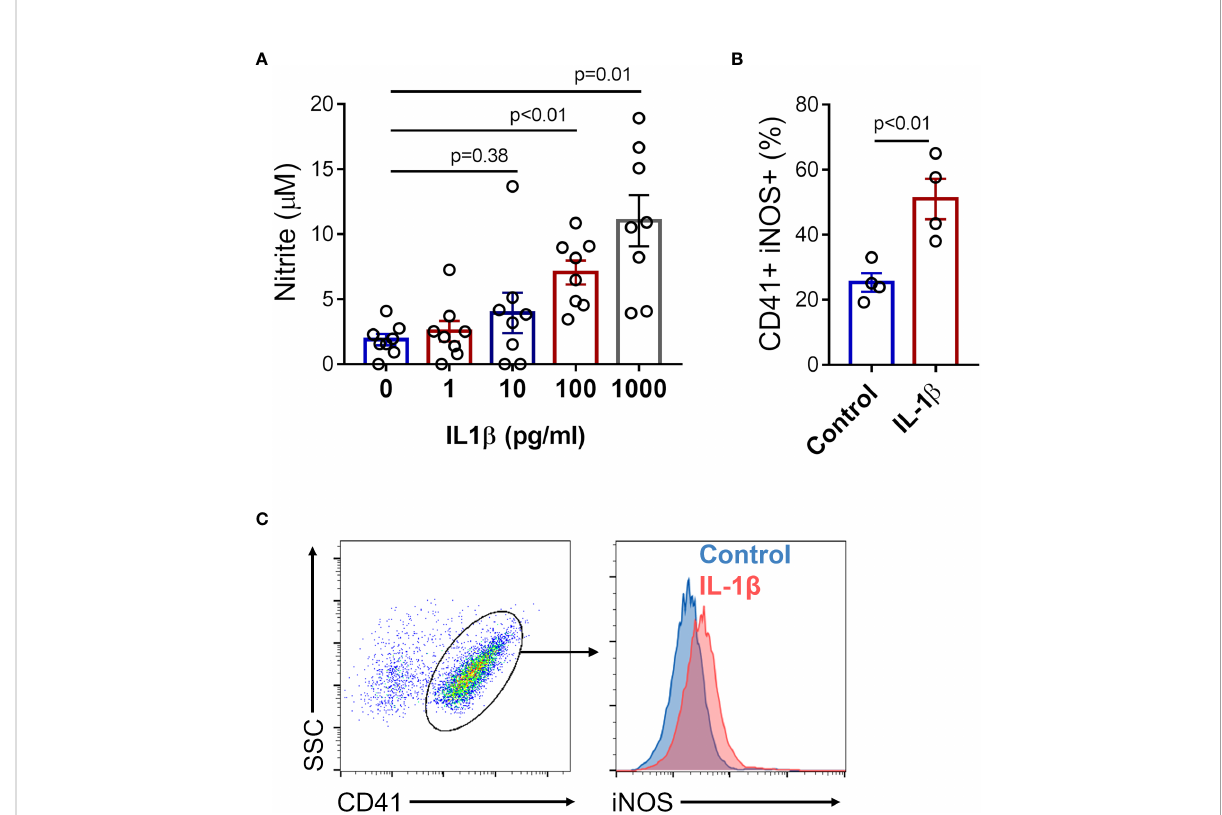
FIGURE 5 IL-1 b induces iNOS expression and NO production in platelets. Platelets from healthy volunteers were stimulated with 1, 10, 100, and 1000 pg/ ml of recombinant human IL-1 b . (A) The nitrite concentration in the supernatant of platelet in each condition is shown. (B) The percent of intracellular iNOS expression in platelets stimulated with 1000 pg/ml of recombinant human IL-1 b . The bars represent the mean ± SEM of 8 (A) or 4 (B) independent experiments with platelets from different healthy volunteers. (C) Gate strategy and representative histogram of one experiment is